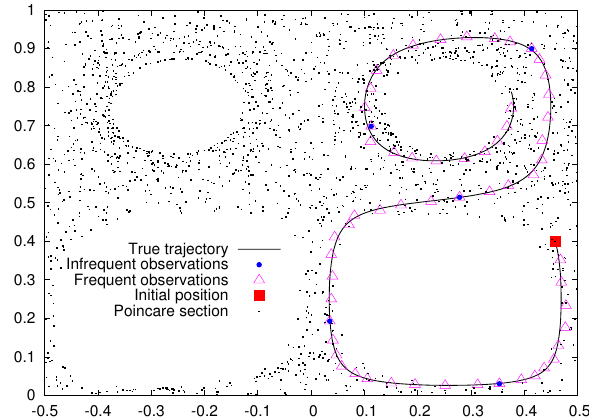
Fig. 9. The trajectory used to study the effect of saddles on data assimilation. Note that the Poincar´e plot, shown by black dots, of this trajectory shows that it is a chaotic trajectory.